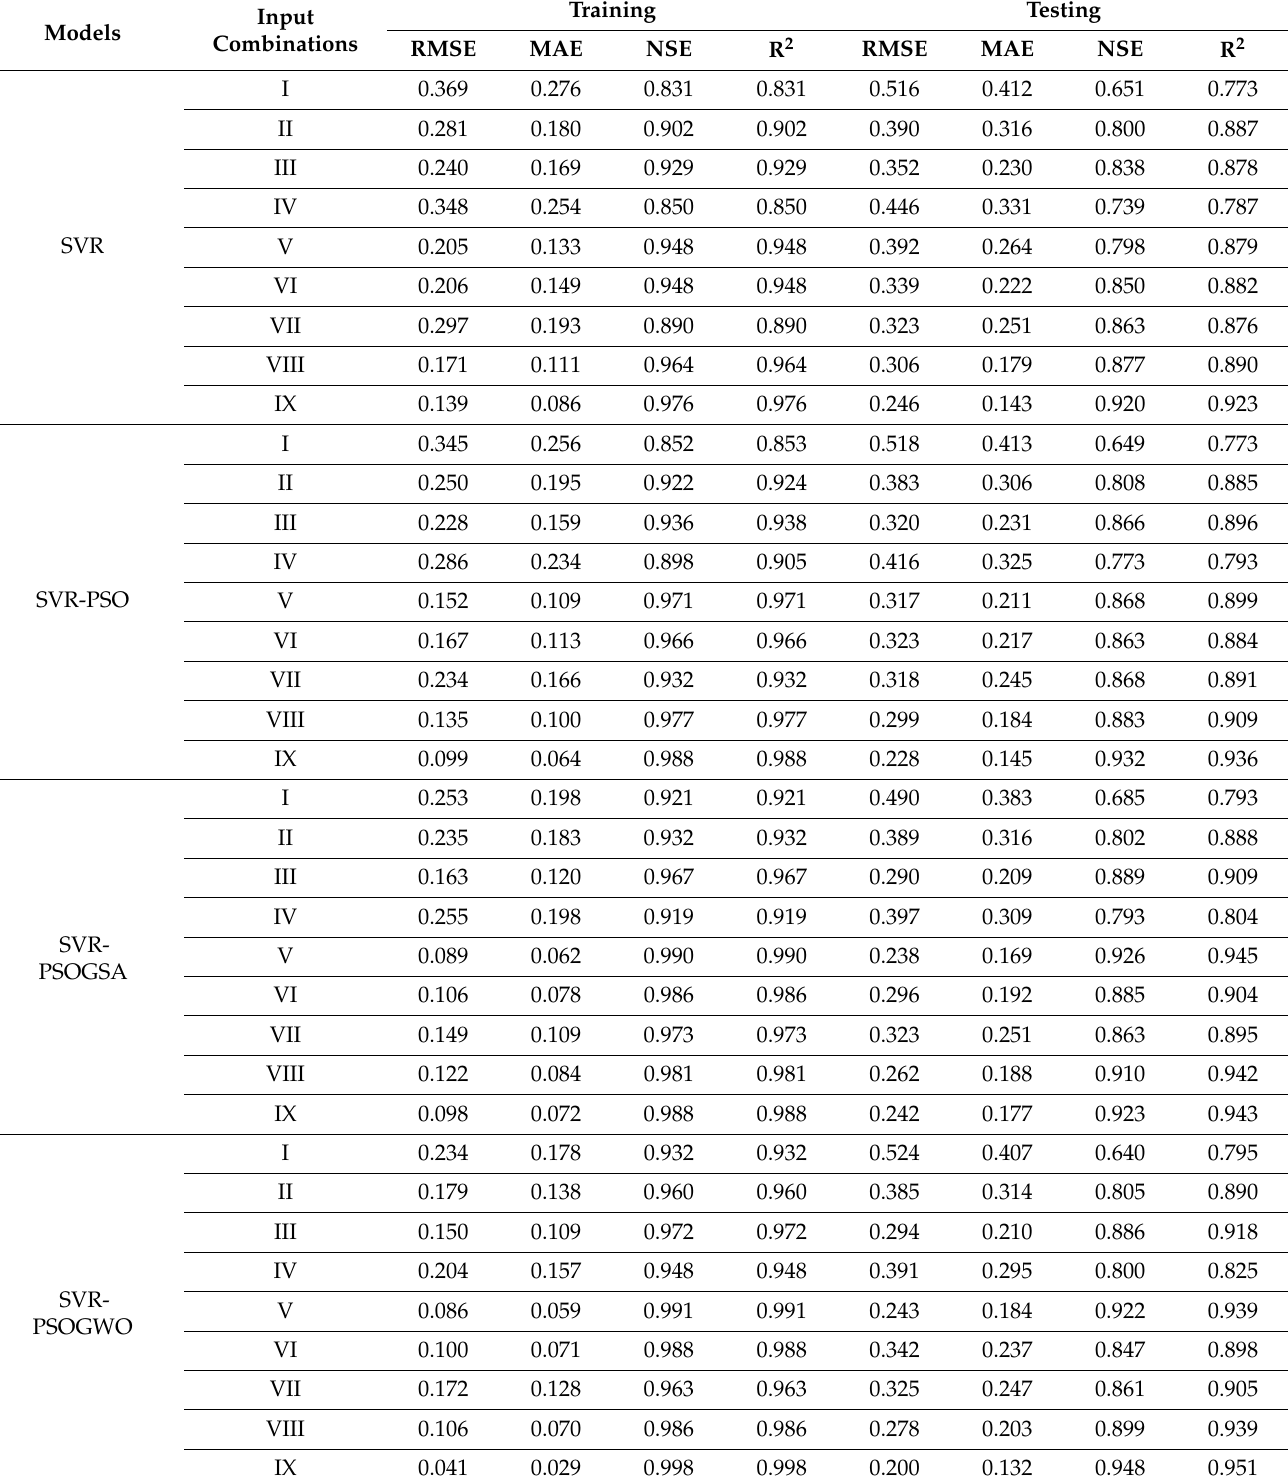
Table 6. The results of Station 3 (Rangpur) using SVR-based